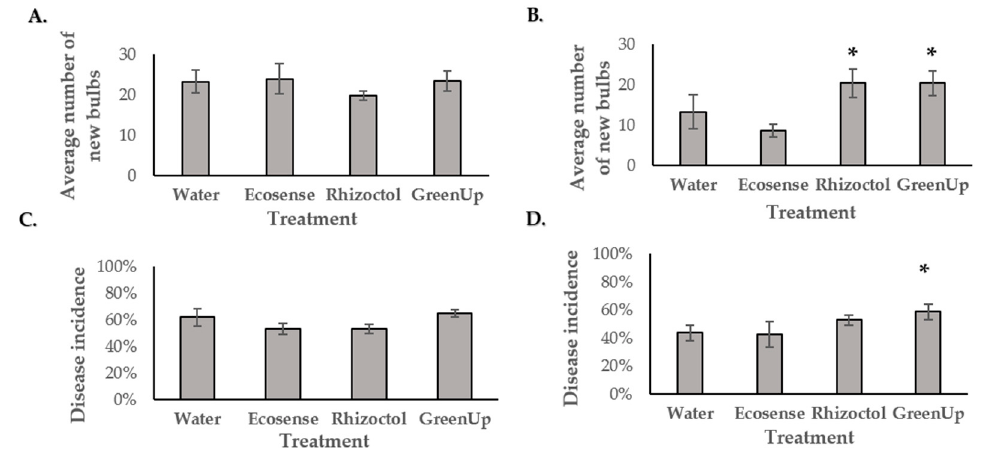
Figure 8. Propagation indices and damage from soft rot disease in Ornithogalum dubium bulbs after each growing season. Average number of new bulbs formed around the mother bulb during the season ( A ) in perlite and ( B ) planting mix. Incidence of soft rot disease ( C ) in perlite and ( D ) planting mix. Naturally occurring soft rot disease incidence was calculated as the average percentage of bulbs showing clear signs of rot (3–5 on the disease index) from all of the replicates for each treatment. Bars represent standard errors. An asterisk above the column signifies a significant difference relative to the control treatment (Student’s t -test, p <